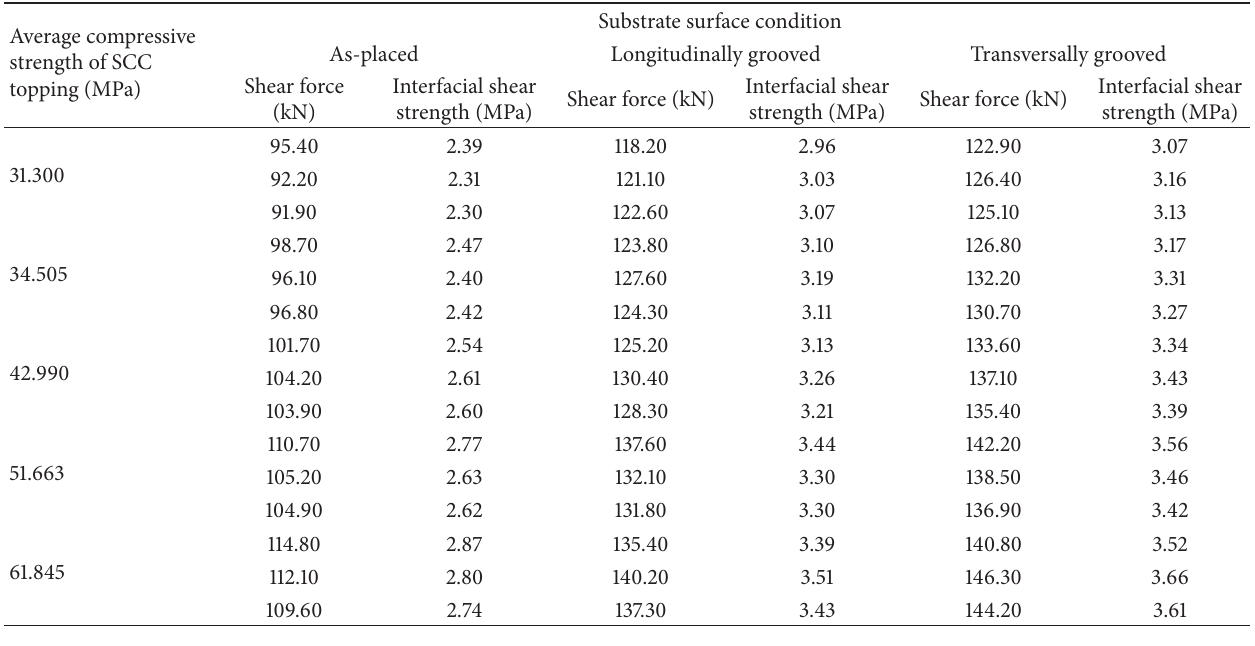
Table 5: Test results on interfacial cohesion with different substrate surface condition.